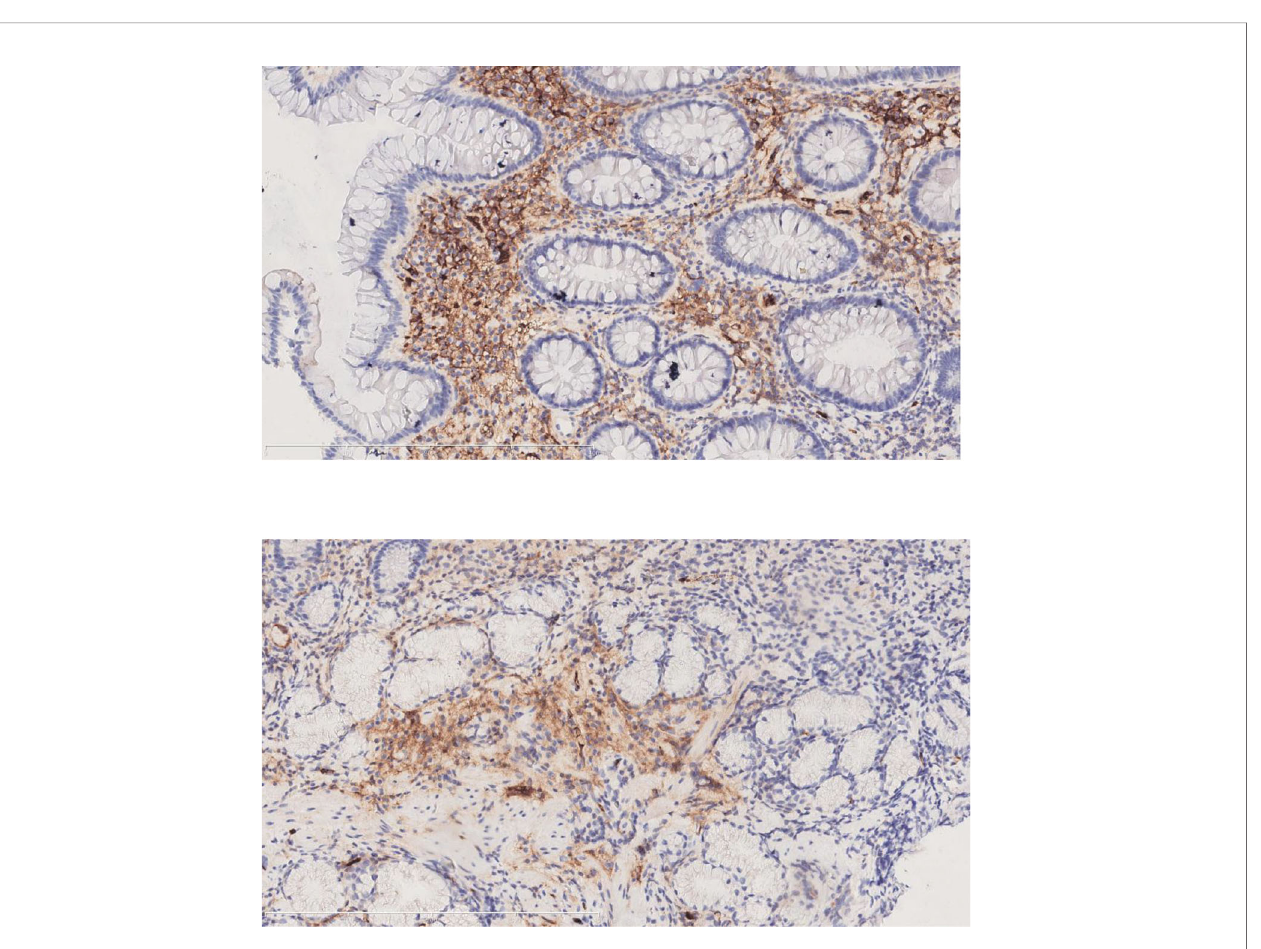
FIGURE 3 | The immunohistochemical staining for IgG4 of the submandibular gland and intestinal polyps (Case 2).